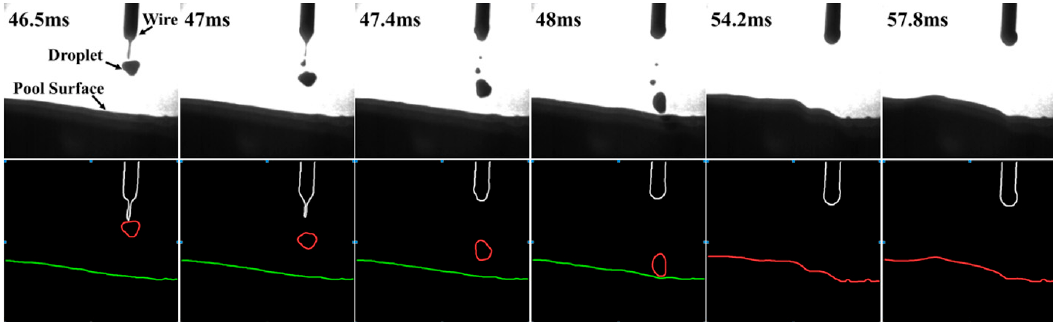
Figure 3. Contour extraction of droplets and weld pool.